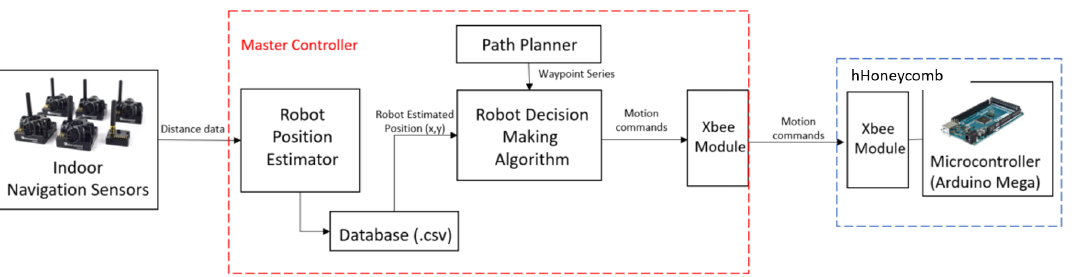
Figure 4. The communication architecture diagram of